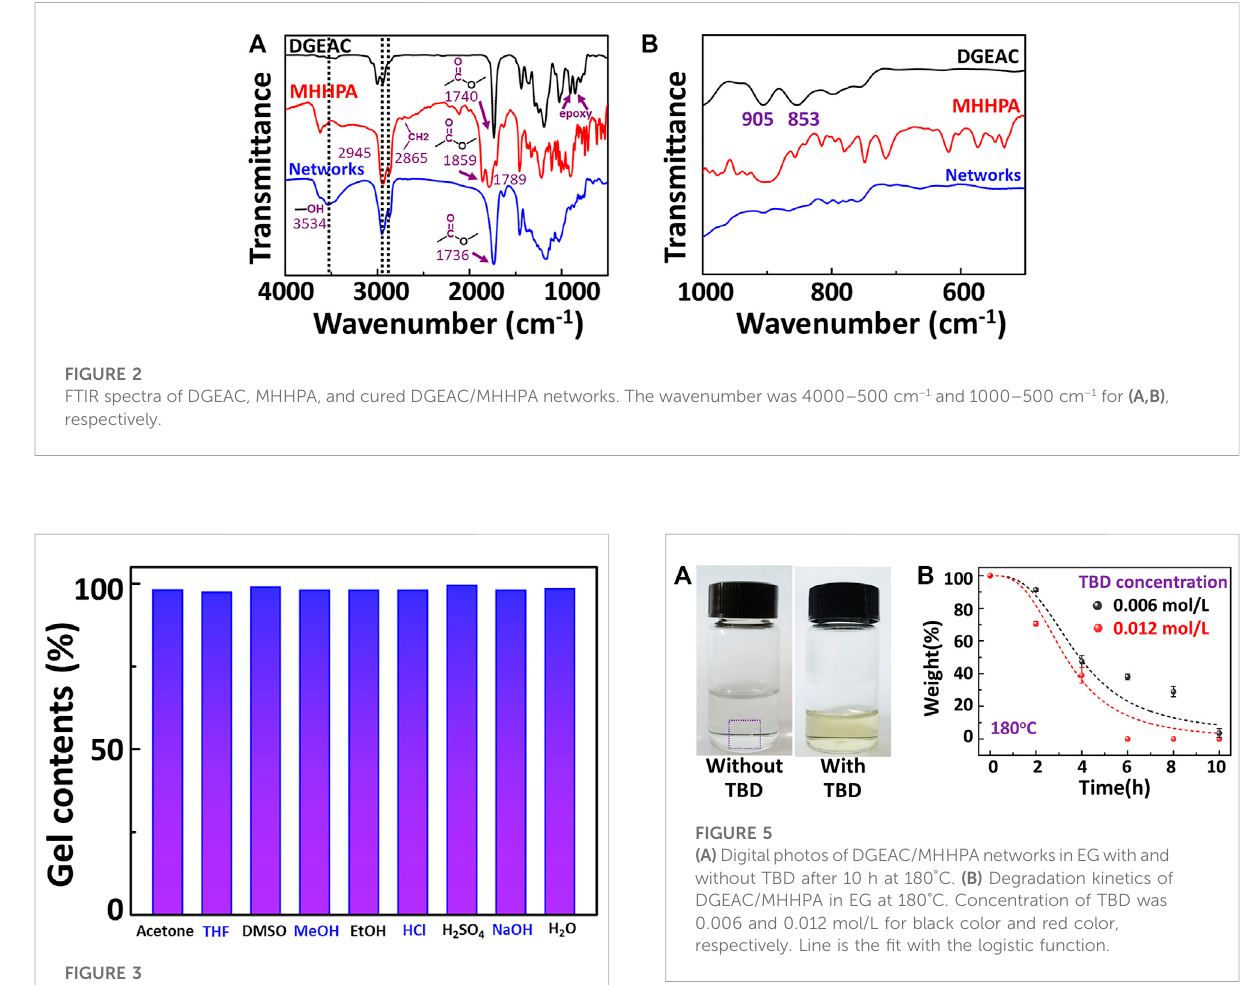
FIGURE 3 Gel contents of DGEAC/MHHPA networks at different solvents for 48 h.